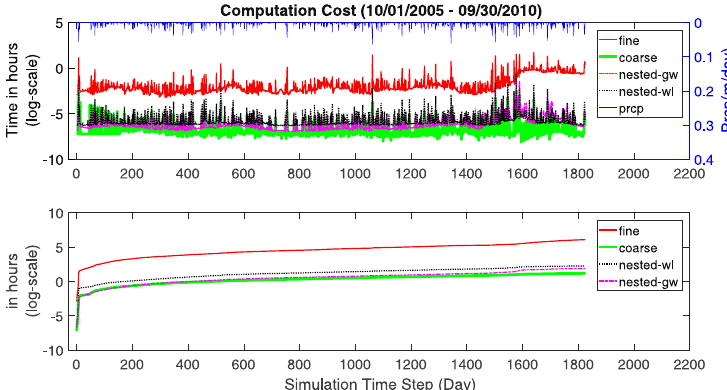
Figure 2. Computation time per one minute simulation step (above) and cumulative computation time (below) for fine, nested-wl, nested-gw, and coarse simulations. Prcp denotes the precipitation time series. Log scale on the y-axis has e ( = 2.718) as its base.